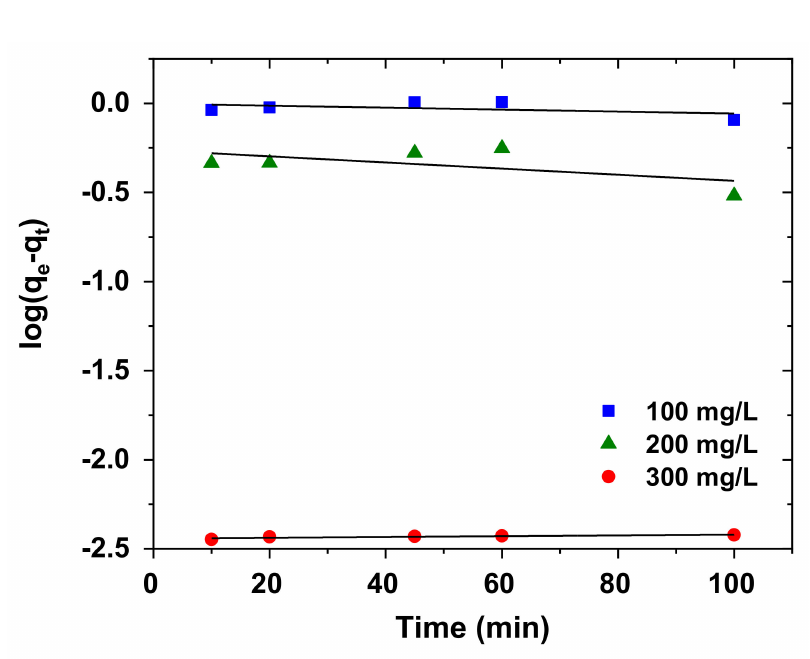
Figure 13. Pseudo-first order kinetic (Lagergren) model for AB92 adsorption onto Nd 2 O 3 nanoparticles at 298